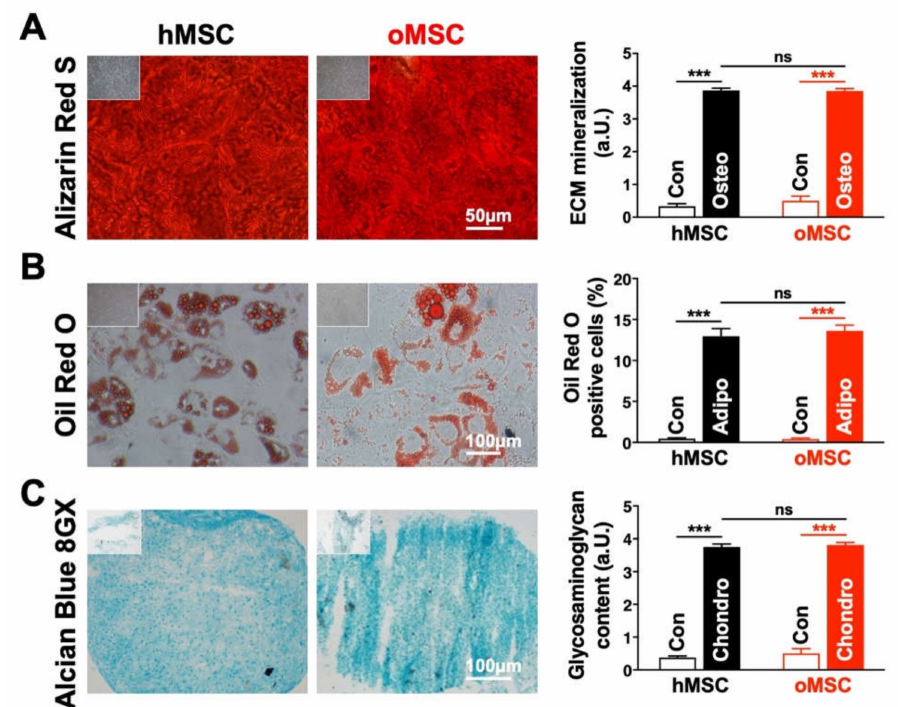
Figure3. Comparableosteogenic, adipogenic, andchondrogenicdi ff erentiationpotential. Mesenchymal stromal cells (MSC) of healthy control donors (hMSC) and osteoporotic donors (oMSC) at passage 3–4 were induced towards ( A ) osteoblast (Osteo), ( B ) adipocyte (Adipo), and ( C ) chondrocyte (Chondro) lineages. MSCs in culture medium without any osteogenic, adipogenic, or chondrogenic induction supplement were used as controls (inserts in the top left corners). Di ff erentiation success was confirmed via ( A ) Alizarin Red S, ( B ) Oil Red O, and ( C ) Alcian Blue 8GX stains. ( A , C, right) The extracellular matrix (ECM) mineralization and glycosaminoglycan content were evaluated using a semi-quantitative score based on the staining intensity and area (see Materials and Methods, 4.7 and 4.8). ( B , right) The Oil Red O staining was determined by measuring the percentage of cells stained positive for Oil Red O using the cellSens Dimension software (see Section 4.6). The same magnification was used for all analyses. Con: control, a.U.: arbitrary unit, ns: not significant. Data are expressed as average ± SD of three donors (adipogenic and chondrogenic di ff erentiation) and five to eight donors (osteogenic di ff erentiation) per group. *** p < 0.001, Student’s t